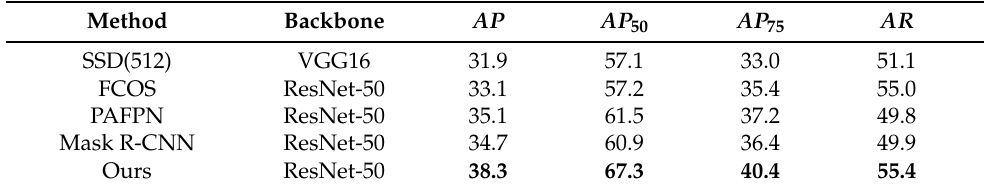
Table 2. Different detection framework result (unit: %